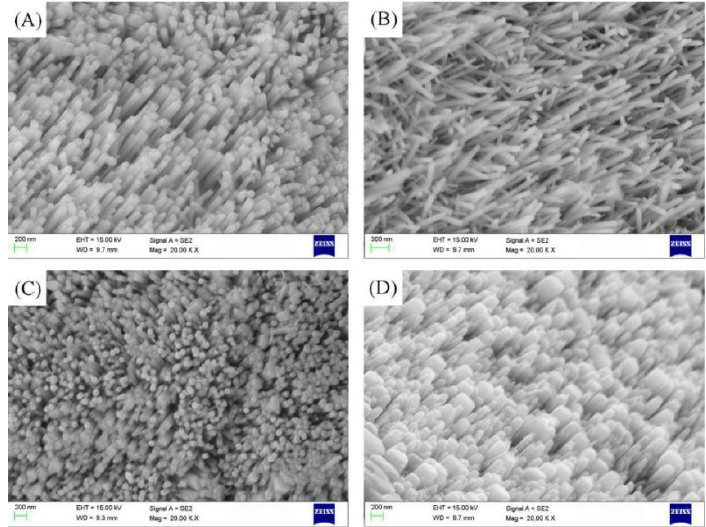
Figure 3. SEM image of ZnO at different reaction times: ( A ) 2 h, ( B ) 3 h, ( C ) 5 h, and ( D ) 6 h.